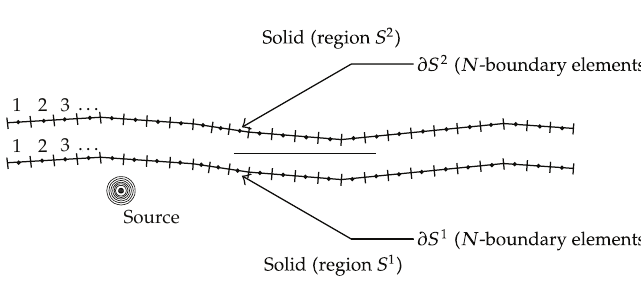
Figure 2: Boundary element mesh for Stoneley’s